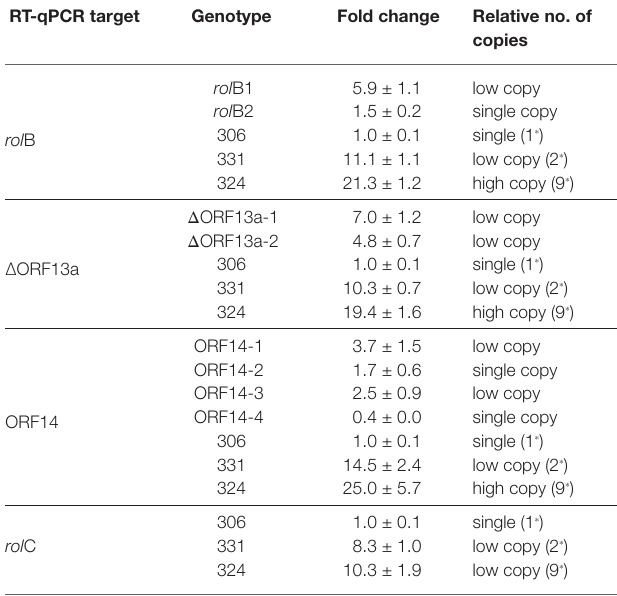
TABLE 2 | Relative copy number of the K. blossfeldiana transgenic lines. RT-qPCR